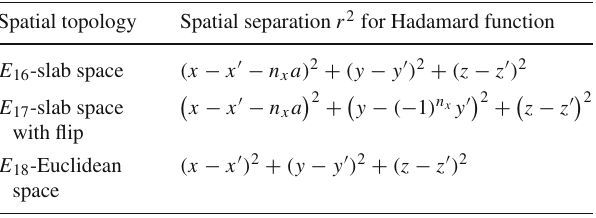
Table 2 Spatial separation in Hadamard function for the simply- connected Euclidean manifold E 18 , and for the multiply-connected flat orientable ( E 16 ) and its non-orientable counterpart ( E 17 ) quotient Euclidean manifolds. The topological compact length is denoted by a . Thenumbers n x areintegersandrunfrom −∞ to ∞ .Foreachmultiply- connected topology, when n x = 0 we recover the spatial separation for the simply-connected Euclidean 3-space Spatial topology Spatial separation r 2 for Hadamard function E 16 -slab